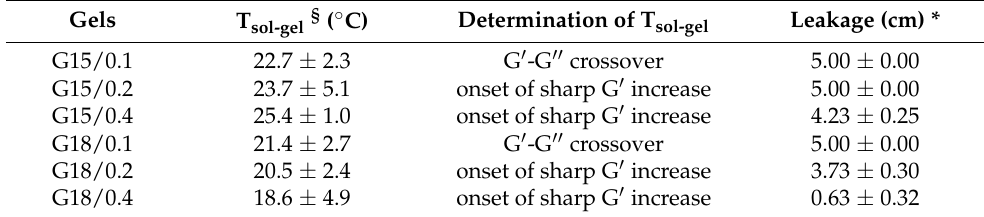
Table 2. Rheological parameters and leakage of the indicated